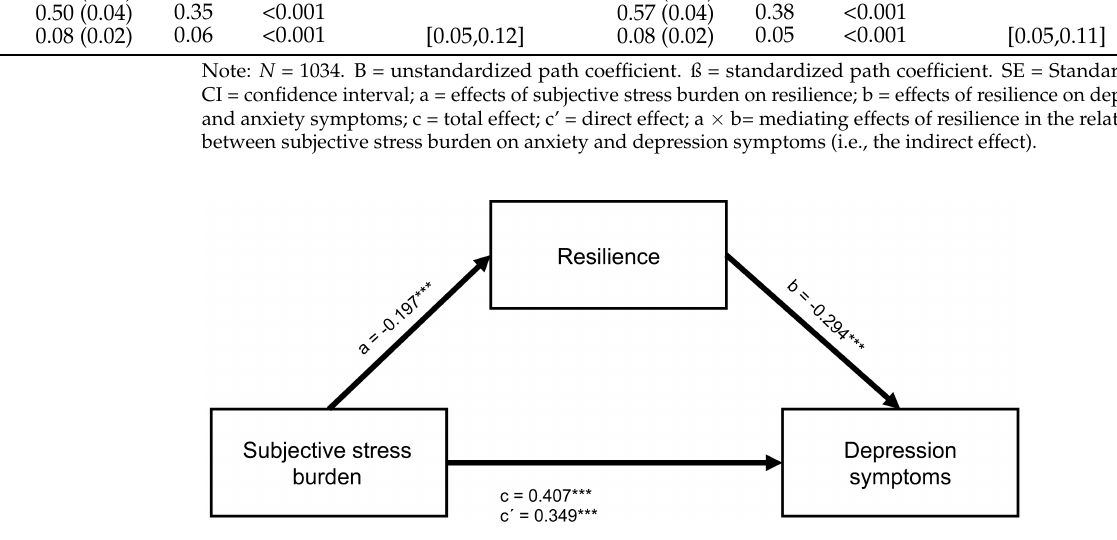
Figure 2. Partial mediation of the relationship between experienced stress and depression symptoms by resilience. Note: N = 1034. Standardized regression coefficients are